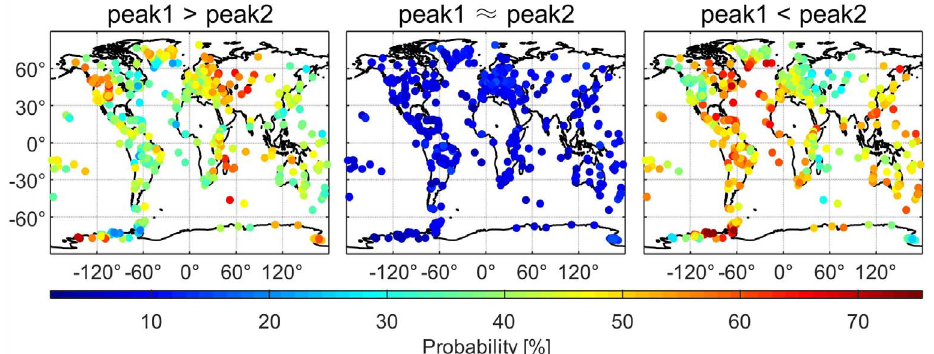
Figure 7. Comparison of the probability of different DDM